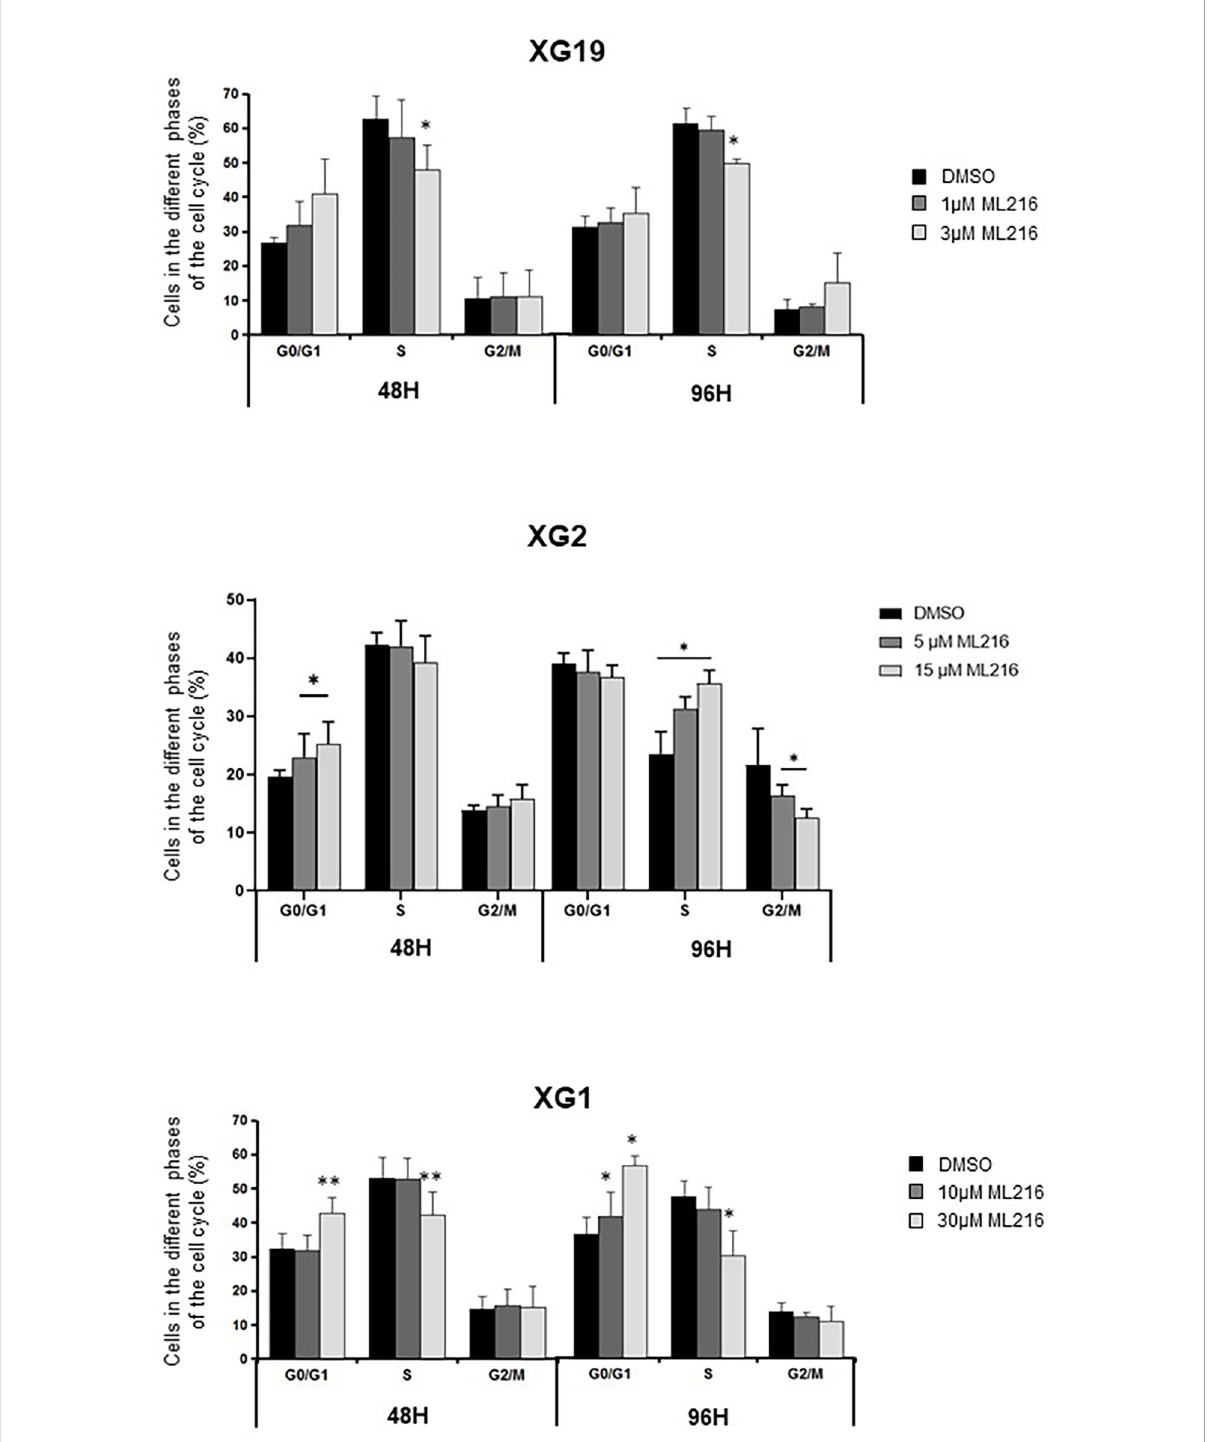
FIGURE 5 ML216 effect on cell cycle distribution in HMCLs. XG19, XG2 and XG1 cell lines were treated for 48 and 96 hours with the indicated concentrations of ML216. BrdU (10 m g/ml) was added during the last 1.5 hours of treatment. Cells were fi xed and processed to detect BrdU incorporation and total DNA (see Materials and Methods for more details). BrdU+ cells were assigned to S-phase. BrdU- cells were assigned to G0/G1 or G2/M phases based on their DNA content. * indicates a signi fi cant difference compared to DMSO treated (control) cells after applying a Student ’ s t-test for pairs. Results are the mean of 3 independent experiments. ** p-value <